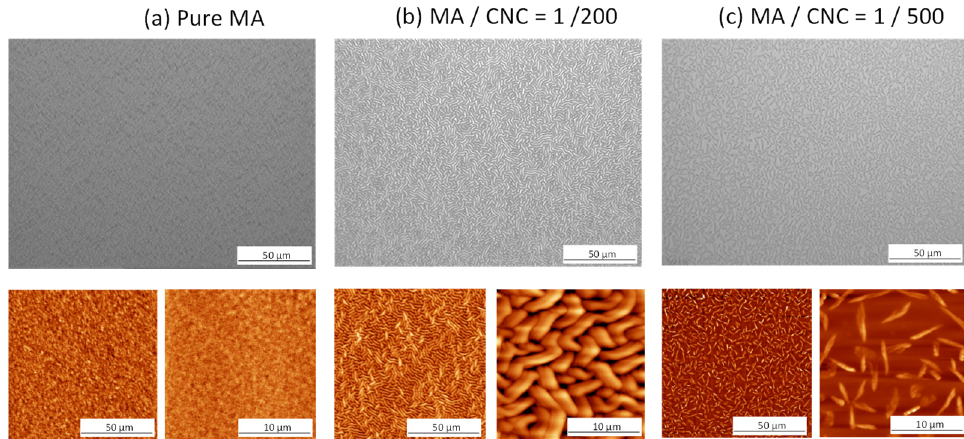
Figure 1. Morphology of pulsed-plasma-polymerized films with different composition, ( a ) pure ma- leic anhydride p(MA) film, ( b ) p(MA+CNC) nanocomposite film with MA/CNC = 1/200, ( c ) p(MA+CNC) nanocomposite film with MA/CNC = 1/500, according to optical microscopy ( top row ) and AFM ( bottom row ).